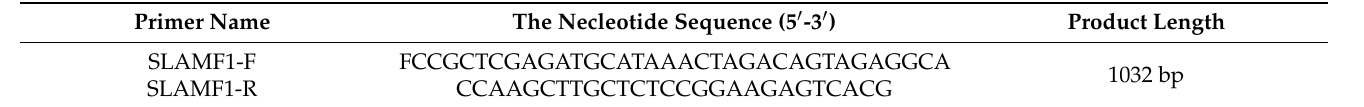
Table 1. Primers for SLAMF1 gene expression.